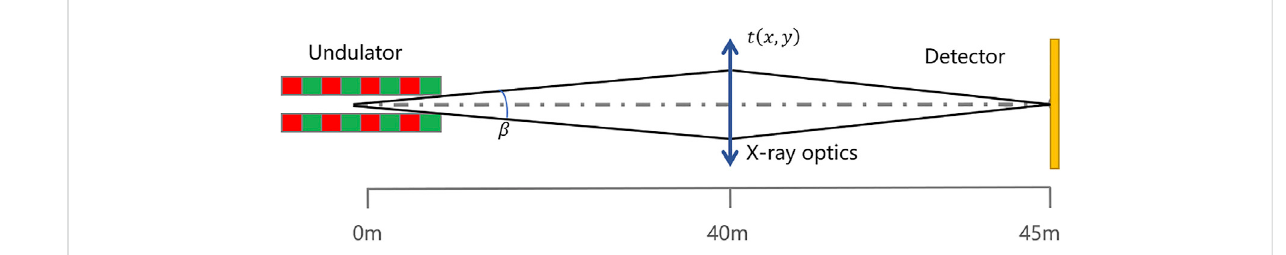
FIGURE 2 Scheme of the beamline system with focusing optics.